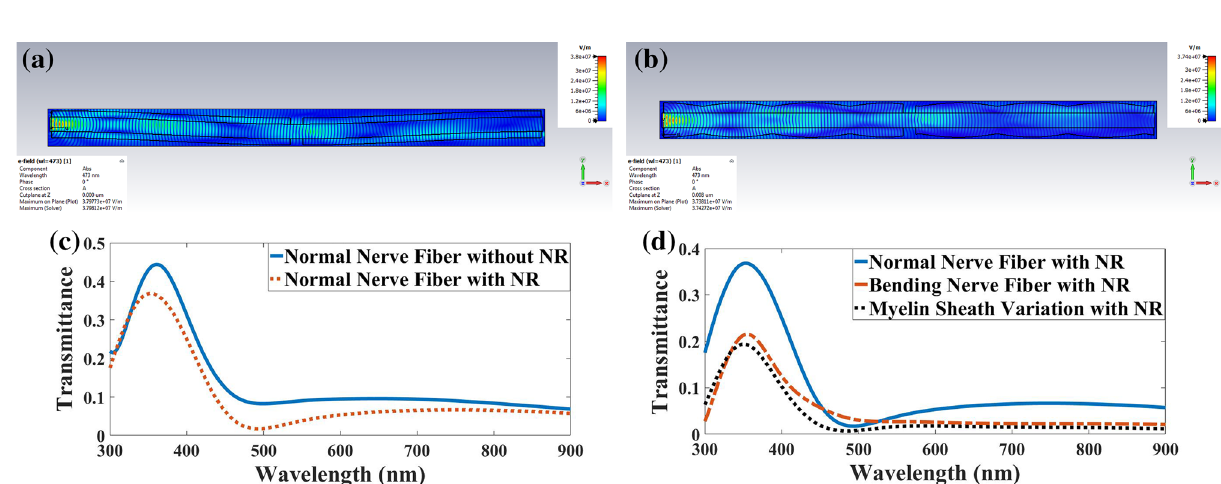
Figure 17. Distribution of the electric field in the myelinated axon with a NR when light is launched to the axon with a ( a ) bending, ( b ) myelin sheath variation. Transmission spectra in normal myelinated axon with ( c ) NR, and ( d ) a bending and myelin sheath variation.